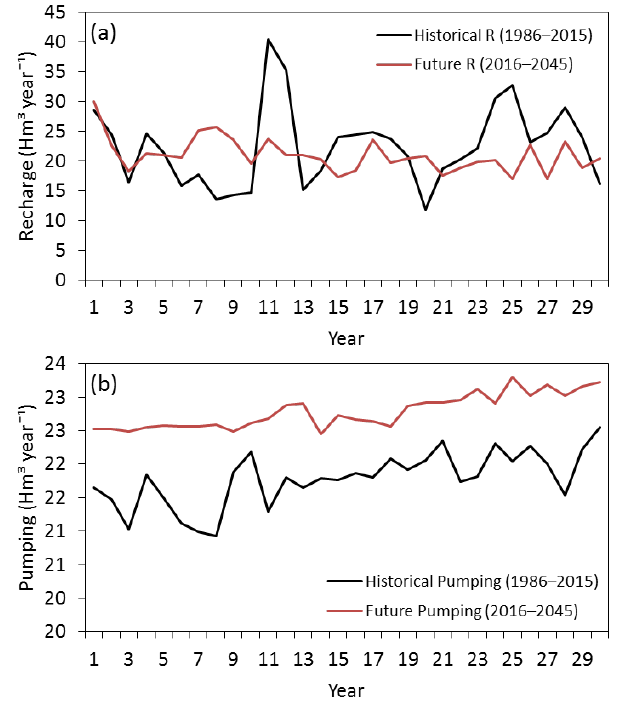
Figure 4. Yearly mean historical and future series of recharge ( a ) and withdrawals ( b ) for the mean year in the periods 1986–2015 and 2016–2045. The historical data were obtained using the methodology proposed by Scott [49] and historical recharge and pumping rates from the Guadalquivir River Basin Plan (2015–2021). The future series were generated by applying the proposed methodology.